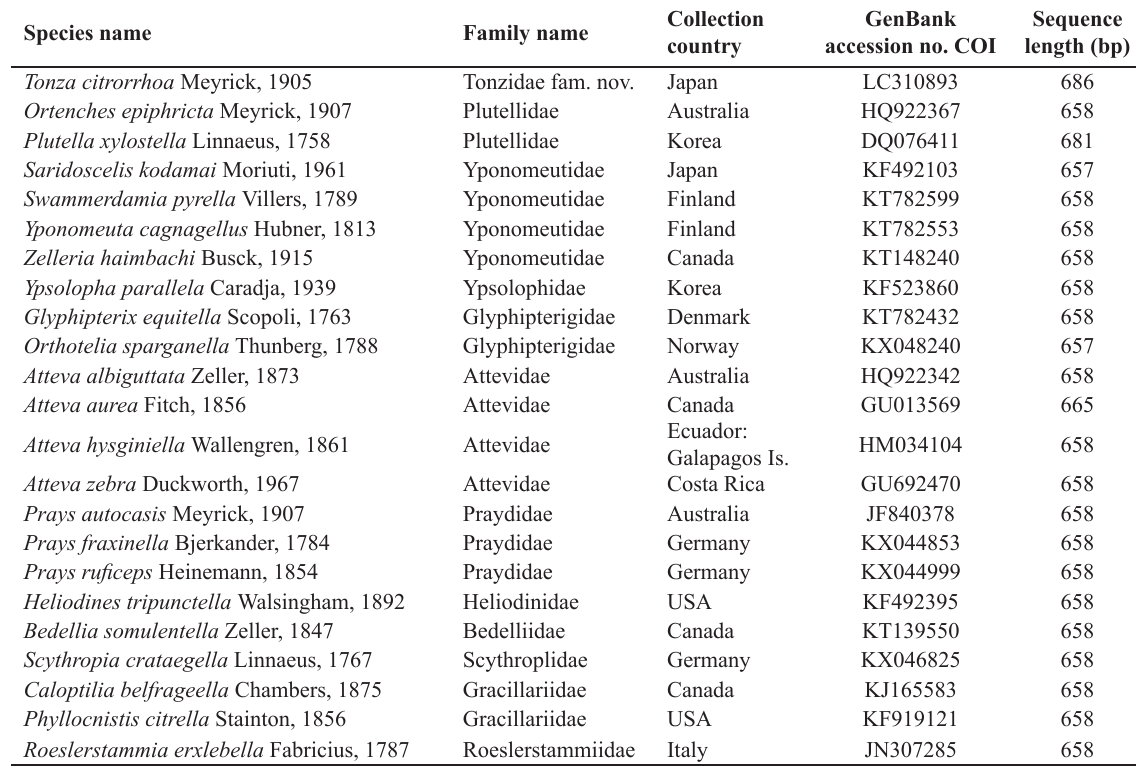
Table 1 . Sampling information and GenBank accession